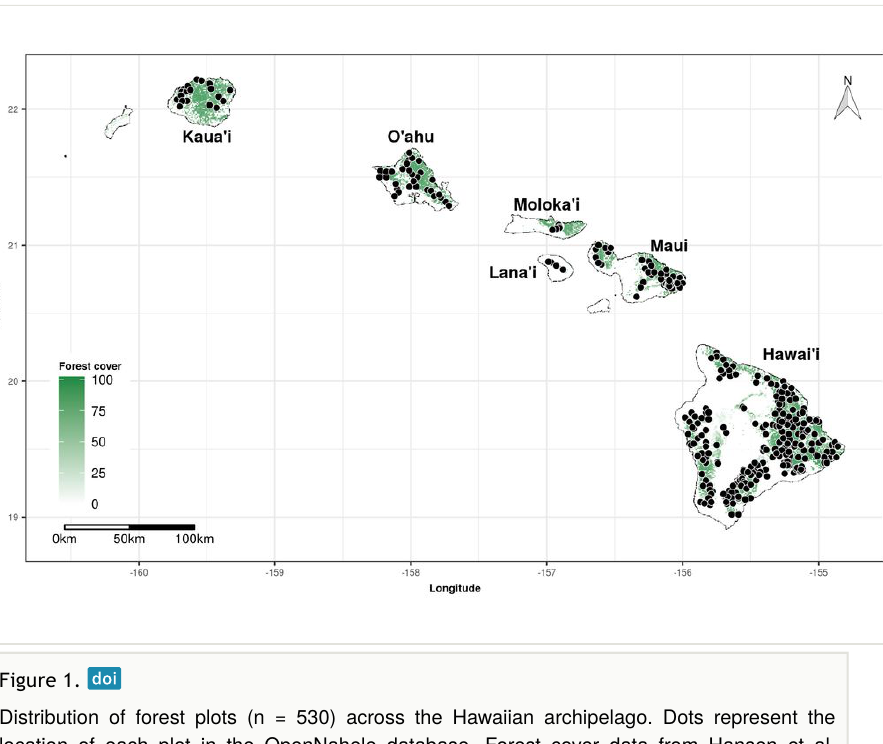
Distribution of forest plots (n = 530) across the Hawaiian archipelago. Dots represent the location of each plot in the OpenNahele database. Forest cover data from Hansen et al.